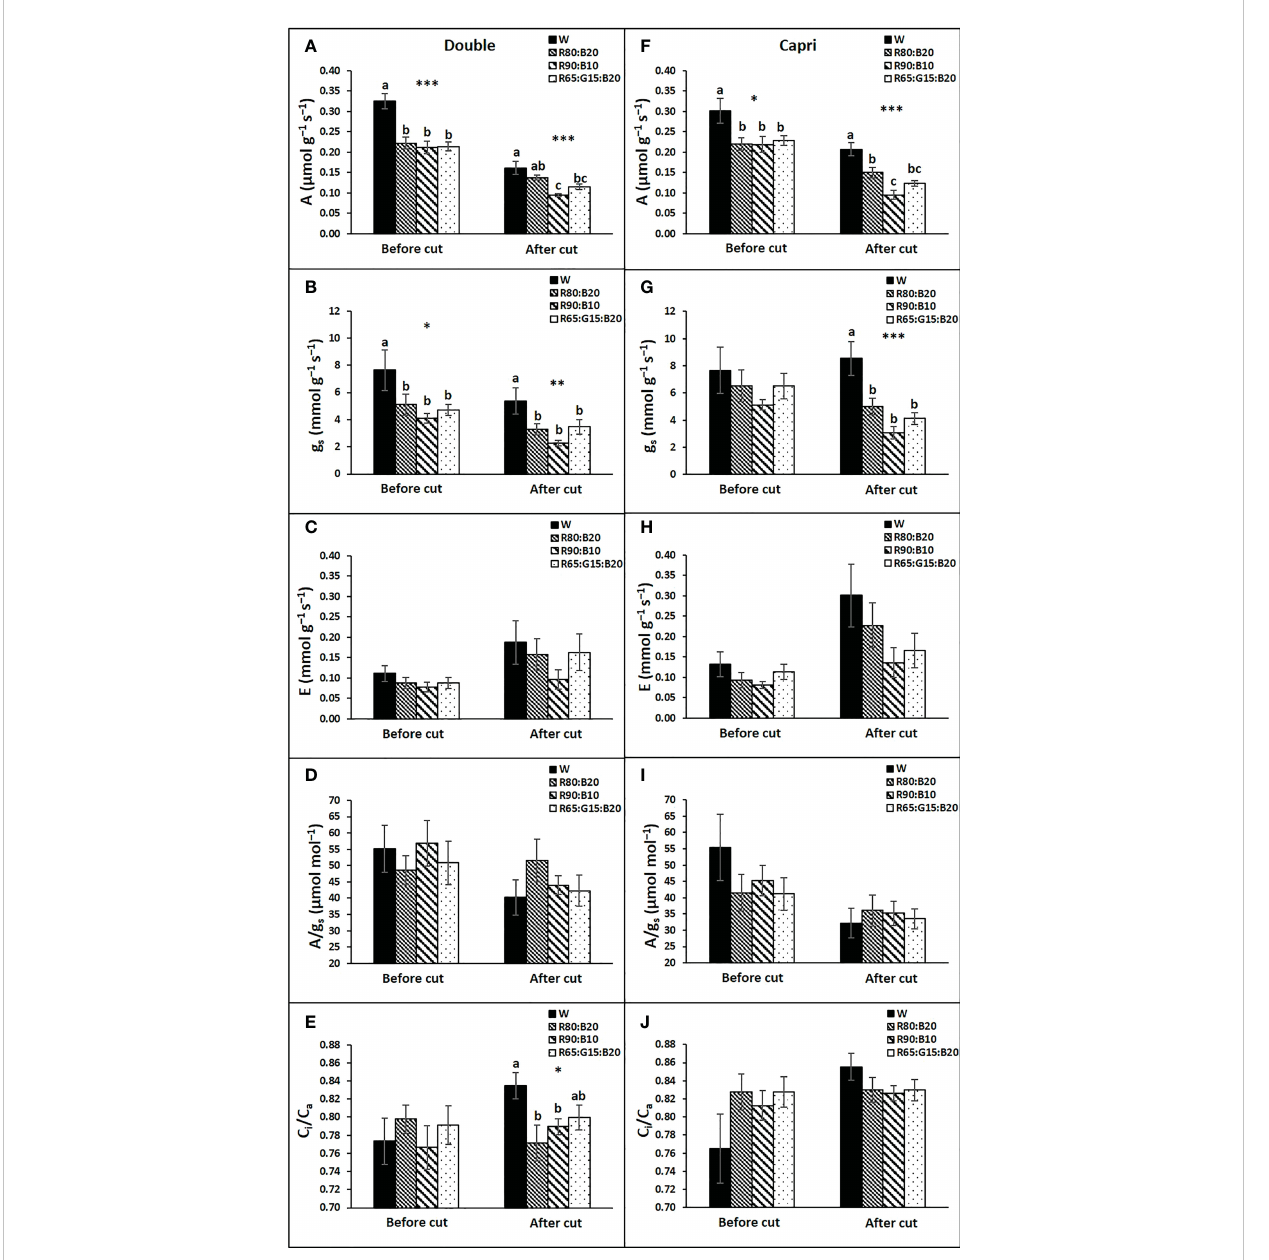
FIGURE 7 Leaf gas exchange responses of perennial ryegrass (cvs. Double, A – E ; cv. Capri, F – J ) to the different LED illumination regimes at 400 m mol m − 2 s − 1 , 100% cool white (W), 80% Red:20% Blue (R80:B20), 90% Red:10% Blue (R90:B10) and 65% Red:15% Green:20% Blue (R65:G15:B20). Net photosynthetic rate (A, A and F ), stomatal conductance (g s , B and G ), transpiration rate (E, C, H) , intrinsic water use ef fi ciency (A/g s , D , I ) and ratio of intercellular to atmospheric CO 2 concentration (C i /C a , E , J ). Each column is average and vertical bars represent the S.E. (n = 18). Different letters indicate signi fi cant differences among the treatments (*, p<0.05; **p<0.01;